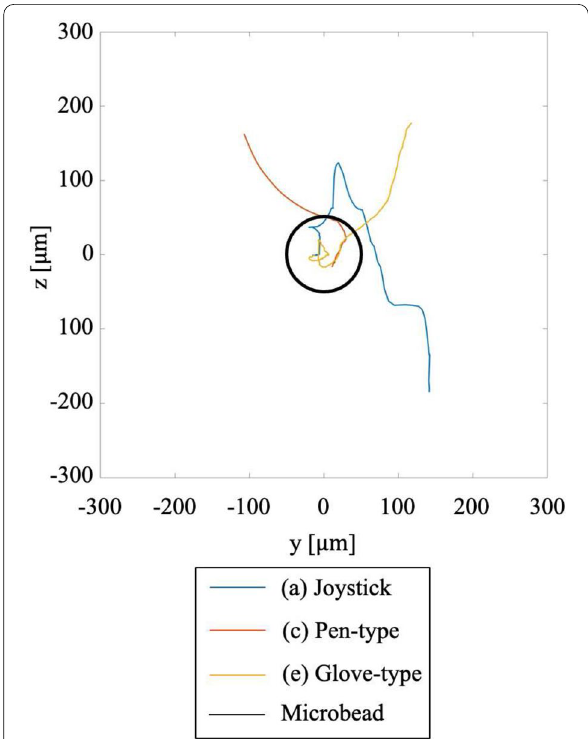
Fig. 21 Trajectories in the xz -plane with 2D image presentation for the evaluation of operation accuracy